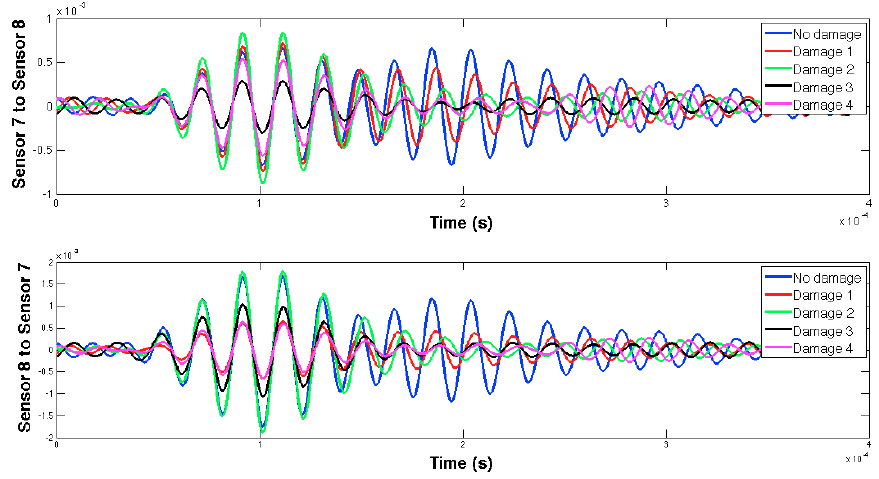
Figure 24. EMPD at 50 kHz. Tone-burst sent and measured between sensors 6 and 7. Sensors 2016 , 16 , 639